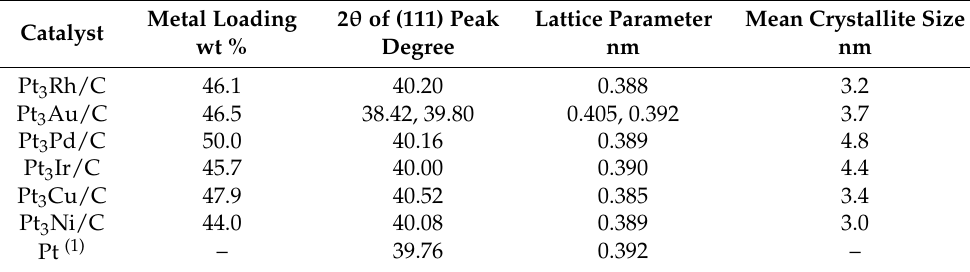
Table 1. Metal loading, 2 θ of (111) peak, lattice parameter and mean crystallite size for Pt 3 M/C (M = Rh, Au, Pd, Ir, Cu and Ni) catalysts.